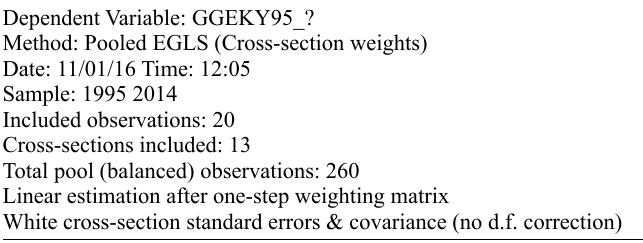
Table 6 Regression parameter estimates for the extended model of less developed